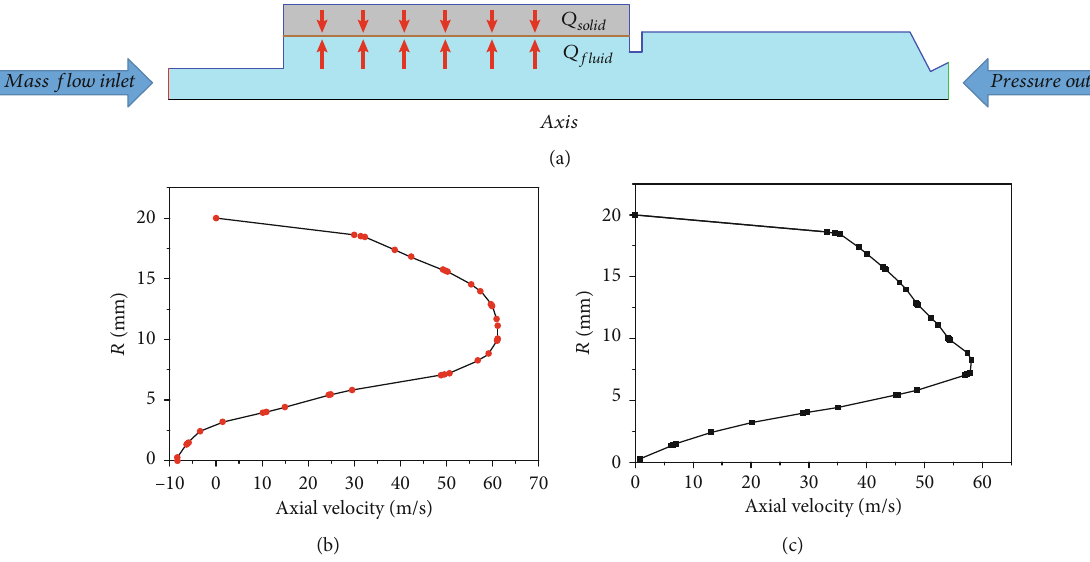
Figure 1: Physical model and inlet velocity pro fi le of the SFRJ used in this investigation.